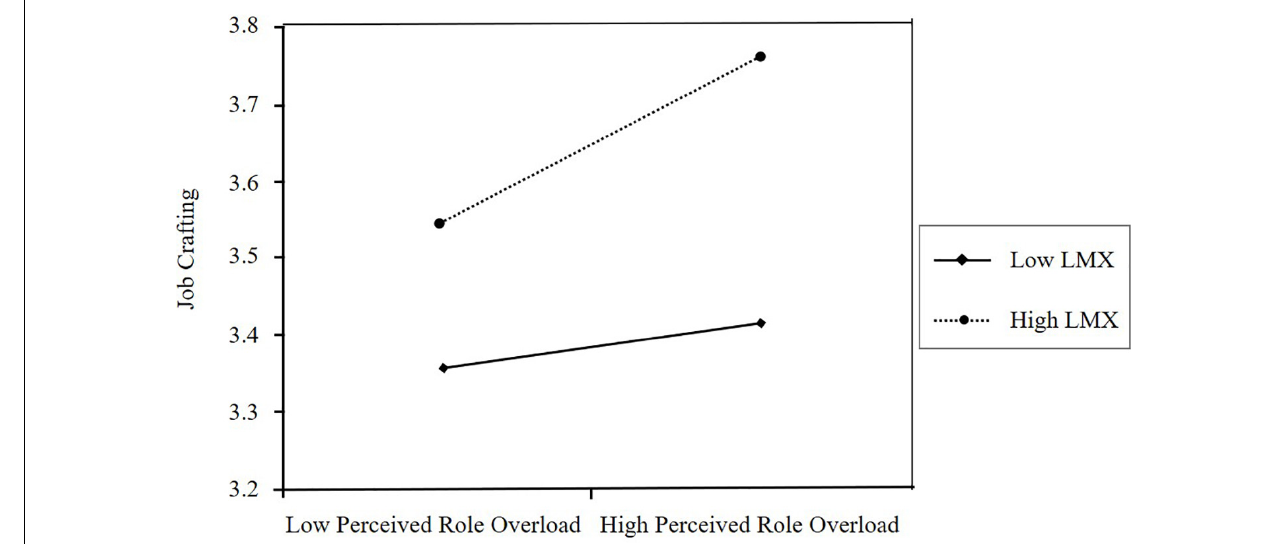
FIGURE 3 | The interactive effect of perceived role overload and LMX on job